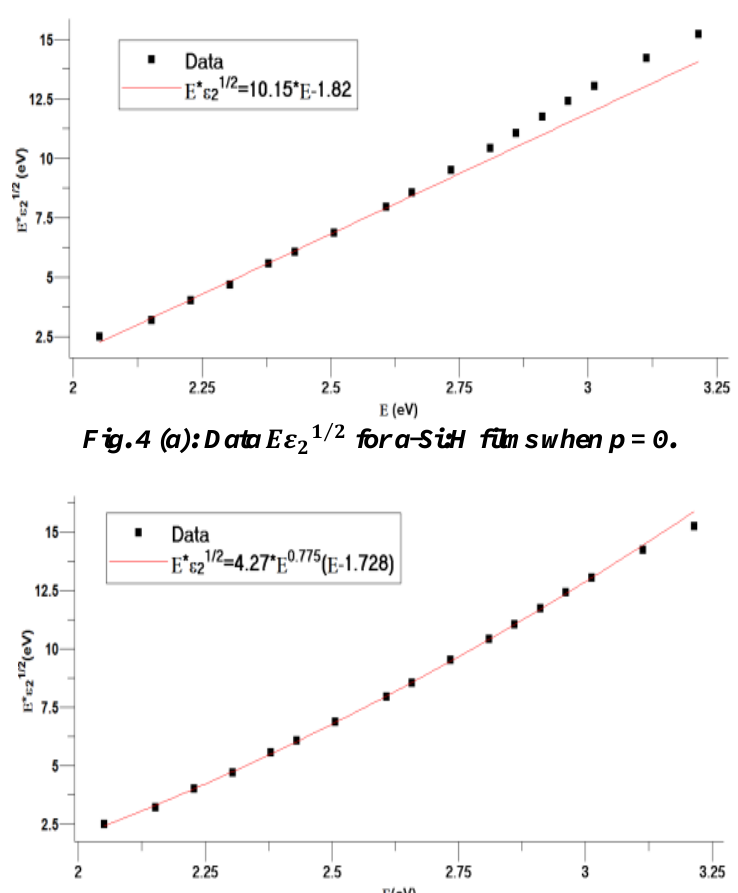
Fig. 4 (b): Data ⁄ for a-Si:H films where p is